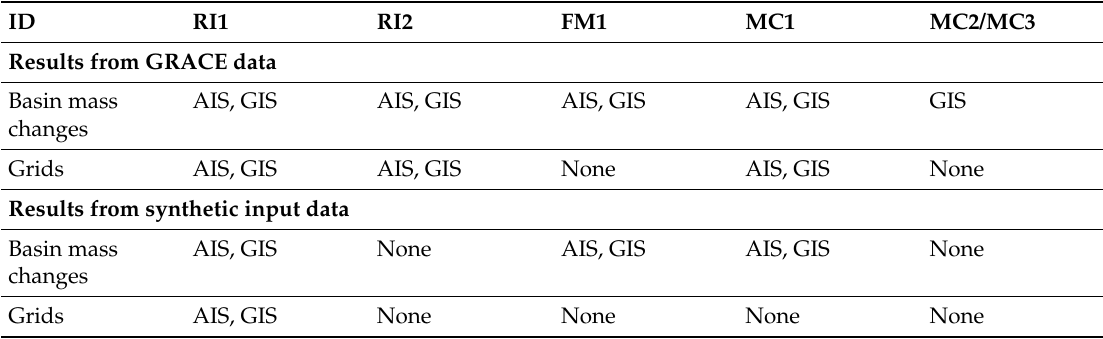
Table 2. Spatial coverage of the results contributed by five groups, derived from GRACE data and synthetic input data. Basin-scale products comprise all prescribed basins and the entire ice sheet (Figure